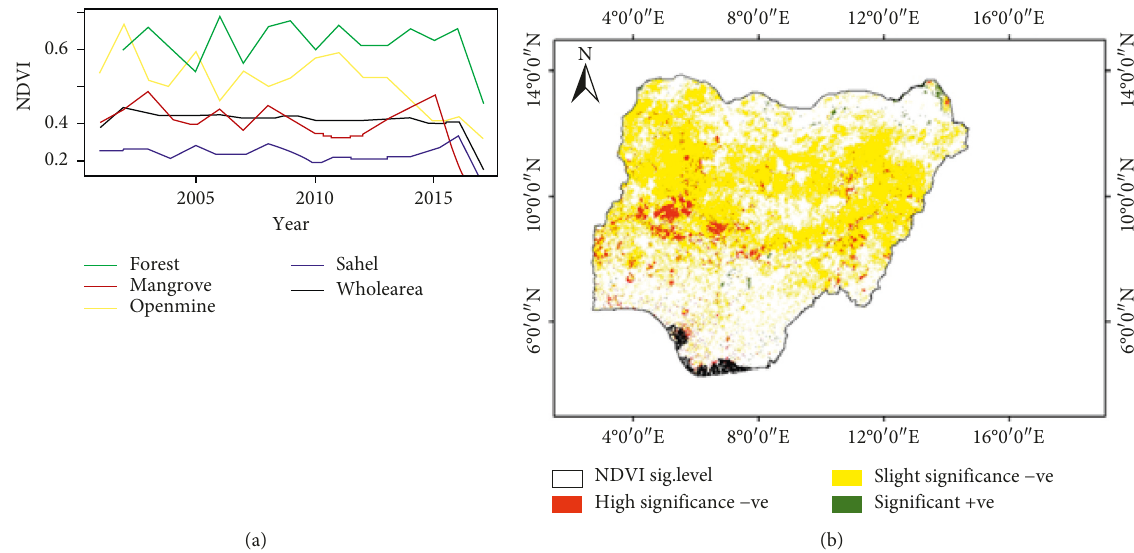
Figure 4: (a) Interannual variability in NDVI based on land cover types and (b) changes in NDVI coefficient of determination ( R 2 ) values at ( p < 0 .